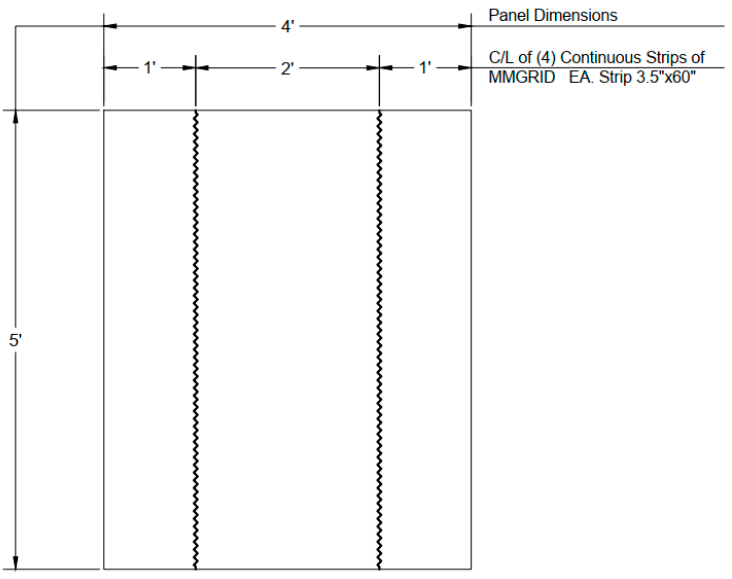
Figure 3. Elevation of all panels showing 24 in (610 mm) spacing between CFRP grid strips.